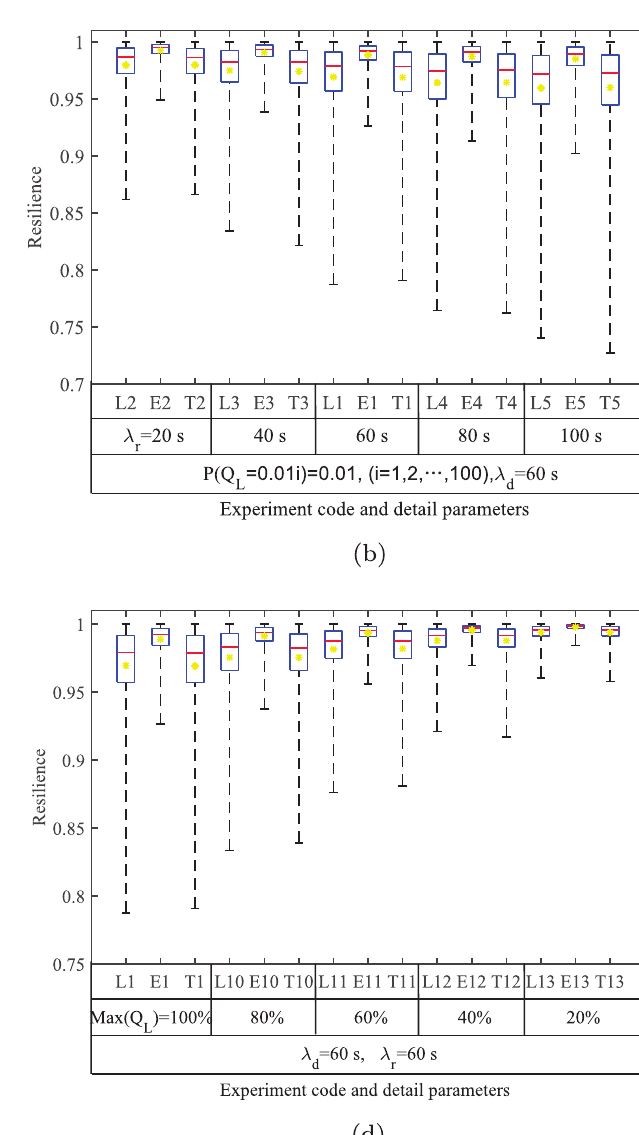
; c) effect of T ; d) effect of Q . The yellow dots d r L D ; 0 : 75 and minimum resilience ℝ , D ; max D ; min